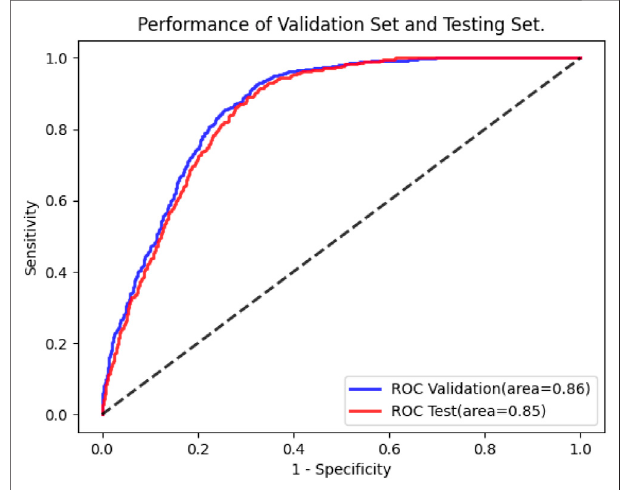
FIGURE 3 | The performance of AI